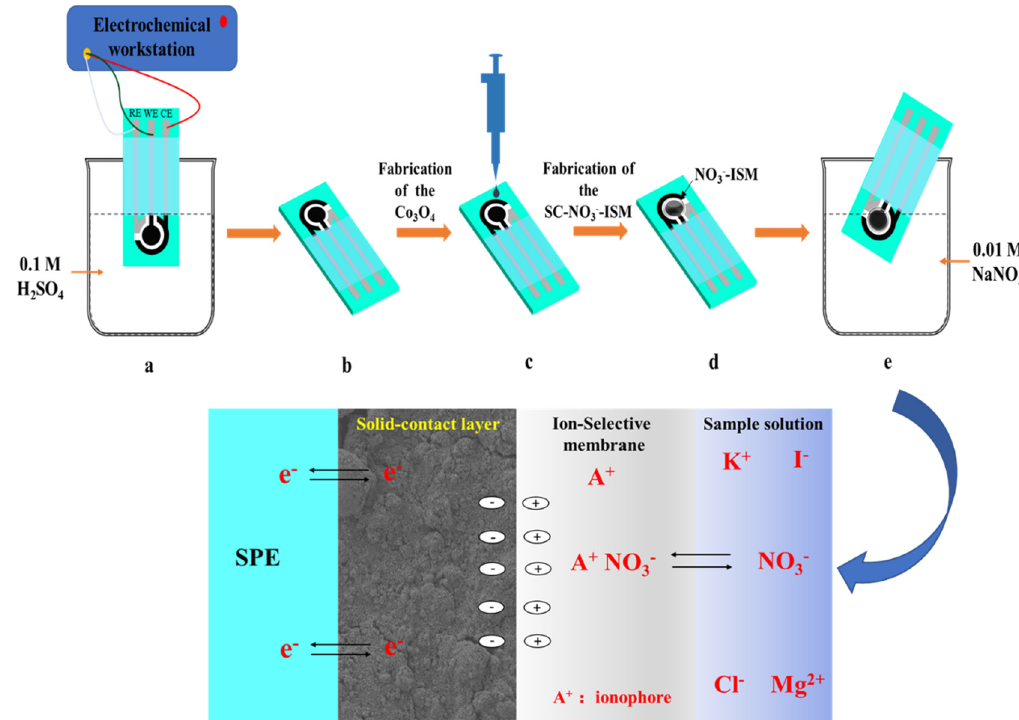
Figure 1. Schematic overview of fabrication of the NO 3 − -ISM/Co 3 O 4 NPs/SPEs.